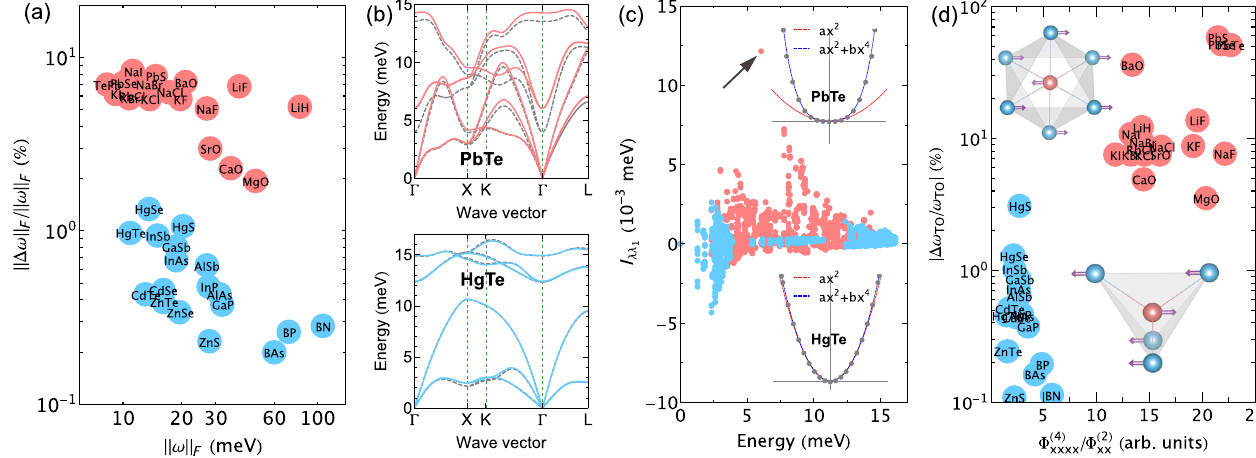
FIG. 3. Phonon frequency shifts when including quartic anharmonicity in selected binary rocksalts (red disks) and zinc blendes (blue disks). (a) Ratio of the Frobenius norm of the shifts in phonon frequencies jj Δ ω jj to the Frobenius norm of the phonon frequencies F jj ω jj as a function of jj ω jj . The self-consistent phonon calculations including quartic anharmonicity are performed at 300 K. F F (b) Phonon dispersions of rocksalt PbTe (upper panel) and zinc blende HgTe (lower panel). The dashed gray lines denote the phonon dispersion from the harmonic approximation, and the colored solid lines denote the phonon dispersion including APRN at 300 K. (c) Strength of the four-phonon interaction matrix elements ( I λλ ) associated with the zone-center transverse optical (TO) phonon mode 1 in the self-consistent phonon formalism (definition in Appendix A) as a function of phonon frequency for PbTe (red dots) and HgTe (blue dots). The black arrow points to the largest value of I λλ in PbTe, with both λ and λ 1 denoting the TO phonon mode. The insets 1 show the PES of the zone-center TO mode for PbTe (upper) and HgTe (lower), respectively. The DFT computed energies are denoted by disks, while the fitted PES using polynomials up to second and fourth order are denoted by red and blue dashed lines, respectively. (d) Ratio of the shift in the frequency of the zone-center TO phonon mode ( Δ ω ) to the harmonic value ( ω ) as a function of the ratio TO TO of quartic on-site interatomic force constants (IFCs) to harmonic IFCs along the x axis. The insets show the atomic displacement vectors associated with the zone-center TO mode for rocksalts (upper) and zinc blendes (lower),